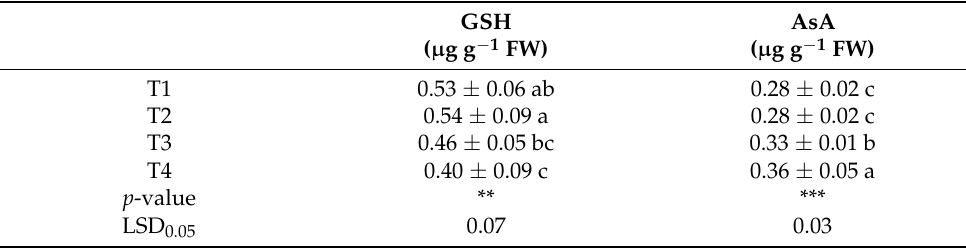
Table 2. GSH and AsA concentrations in spears from the four different plots: untreated control (T1), Brassica pellets (T2), chicken manure pellets (T3), and Dazomet (T4).